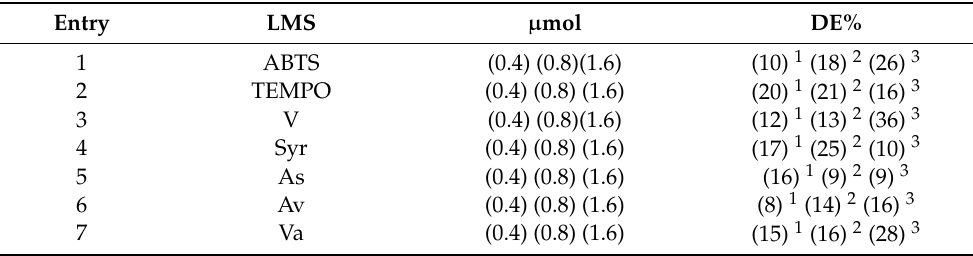
Table 1. Decolorization efficiency of eumelanin by LMS at different amounts of mediators (0.4, 0.8, and 1.6 µ mol).